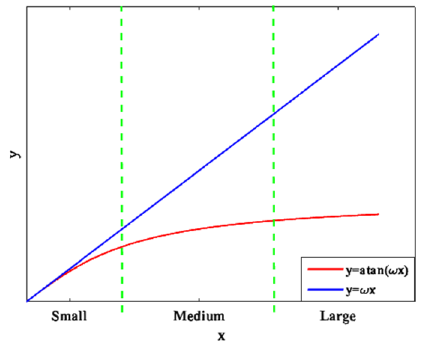
Figure 3. The sketch map of arc tangent and linear function.